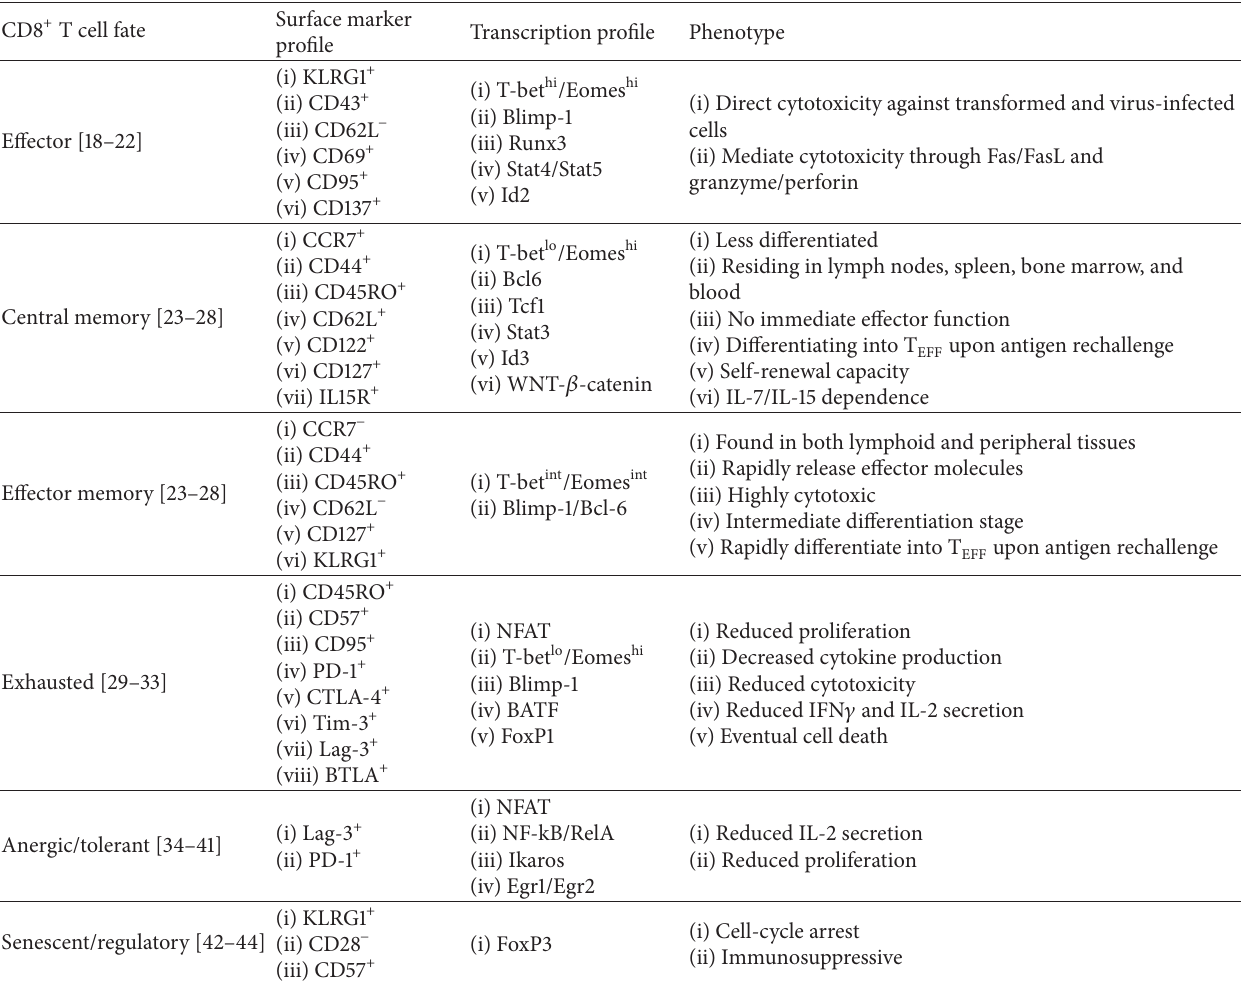
Table 1: Classification of human CD8 + T cell fates based on surface markers, transcription profiles, and observed phenotype. CD8 + T cell